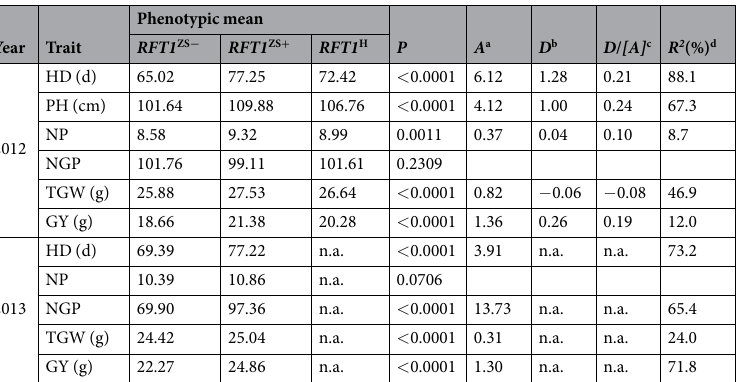
Table 5. Effects of RFT1 ZS97 in a segregating population derived from a heterozygous T 1 plant. RFT1 ZS + and RFT1 ZS − are positive and negative homozygous transgenic lines, respectively. RFT1 H are segregating lines derived from the RFT1 ZS + / RFT1 ZS − heterozygotes. The numbers of lines tested were 14 for RFT1 ZS + , 23 for RFT1 ZS − , and 24 for RFT1 H . They were grown in Hangzhou using a randomized complete block design with two replications. HD, heading date. PH, plant height. NP, number of panicles per plant. NGP, number of grains per panicle. TGW, 1000-grain weight. GY, grain yield per plant. a A , additive effect of replacing a Zhonghua 11 allele with a ZS97 allele. b D , dominance effect. c D /[ A ], degree of dominance. d R 2 , proportion of phenotypic variance explained by the QTL effect. n.a., not